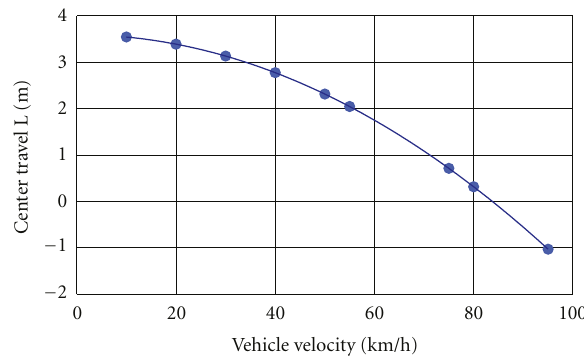
Figure 10: Relationship between amount of center travel L and the vehicle